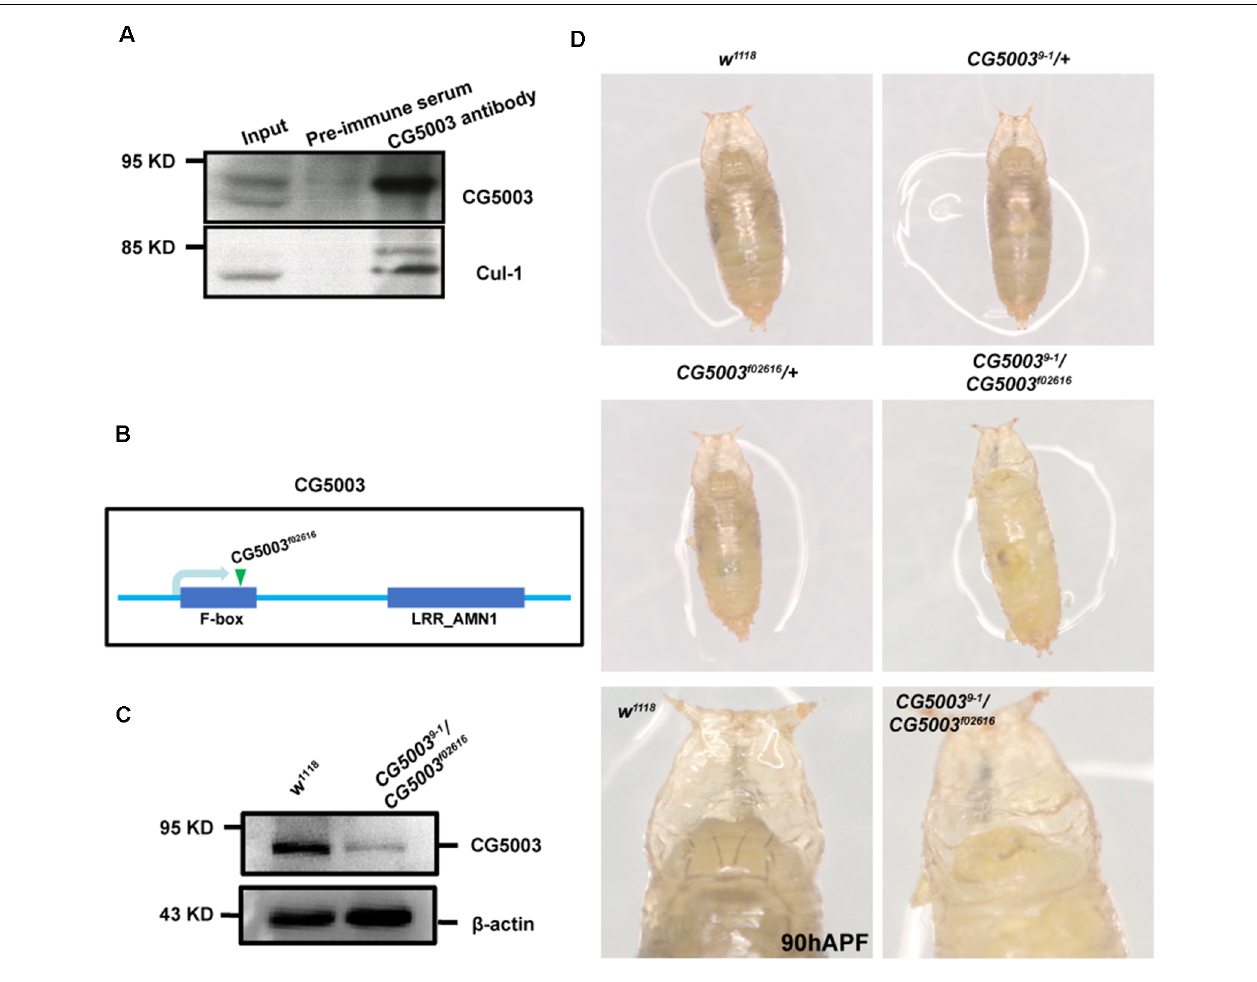
FIGURE 1 | 9-1/f02616 is a CG5003 mutant fly line. (A) Representative western blot images for CG5003 and Cul-1 interaction. Note that endogenous CG5003 proteins are in the same eluates with Cul-1, as pulled down by the anti-CG5003 antibodies. (B) Schematic diagram on CG5003 gene region. Note that f02616 is a p-element insertion line located at the second exon. (C) Representative western blot images for analyzing CG5003 protein levels in the 9-1/f02616 mutants. Note a decrease in the CG5003 protein levels in the trans-heterozygotes. (D) Representative images of fly pupae with the indicated genotypes at 90 h after puparium formation (APF). Note that white-eye 9-1/f02616 mutant pupae exhibit head eversion normally in a similar time scale with the